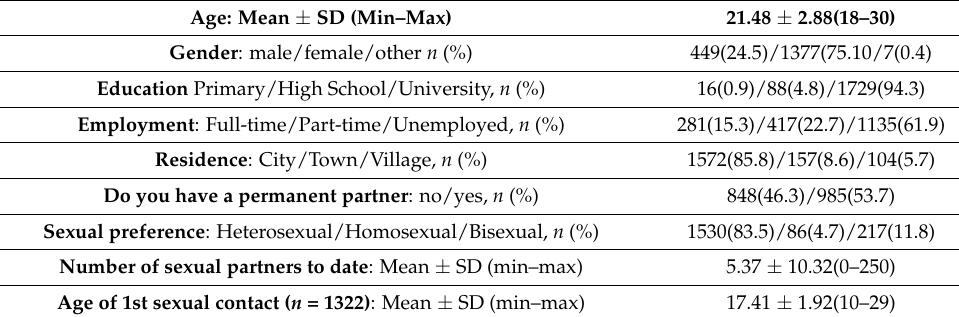
Table 1. Demographic characteristics of the population